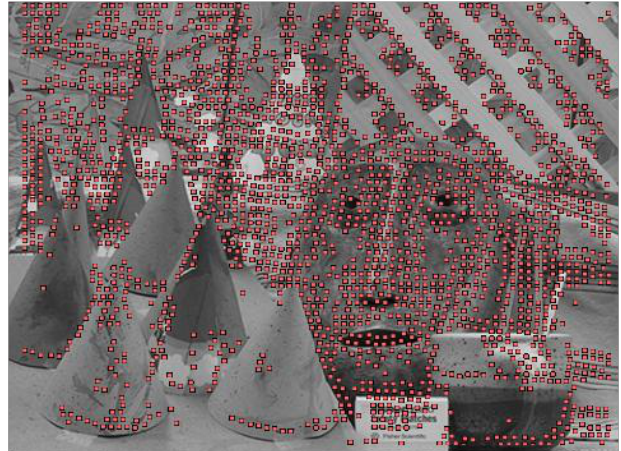
Figure 5. Entropy areas used as matching candidates.